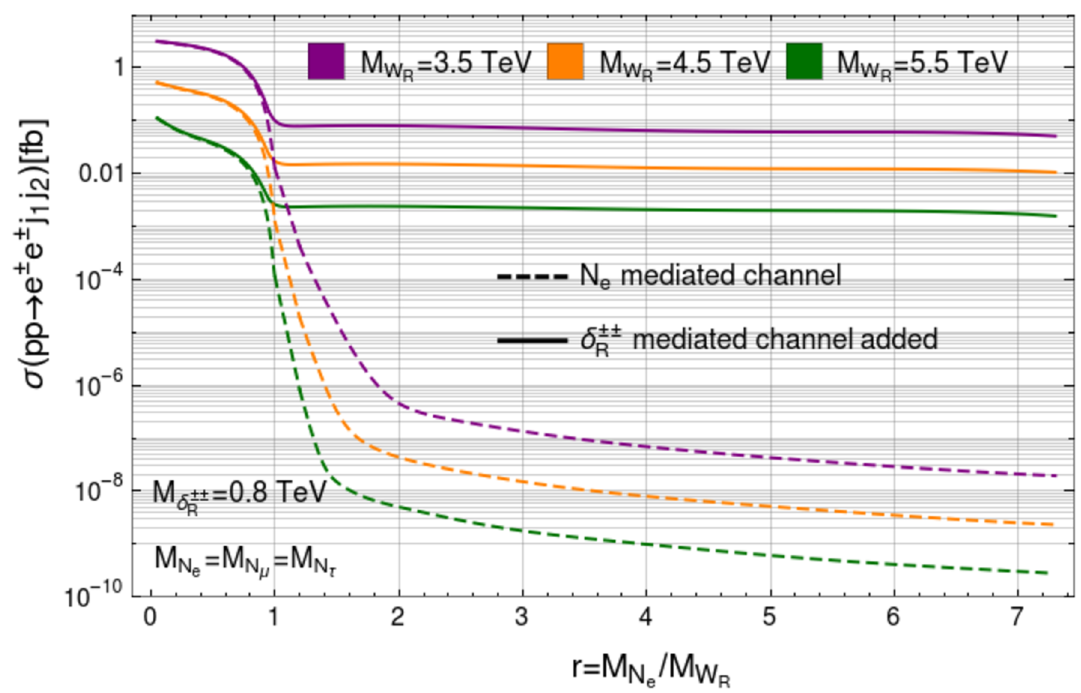
Figure 4. Cross sections for the pp → W ± added contributions of the pp → W ±